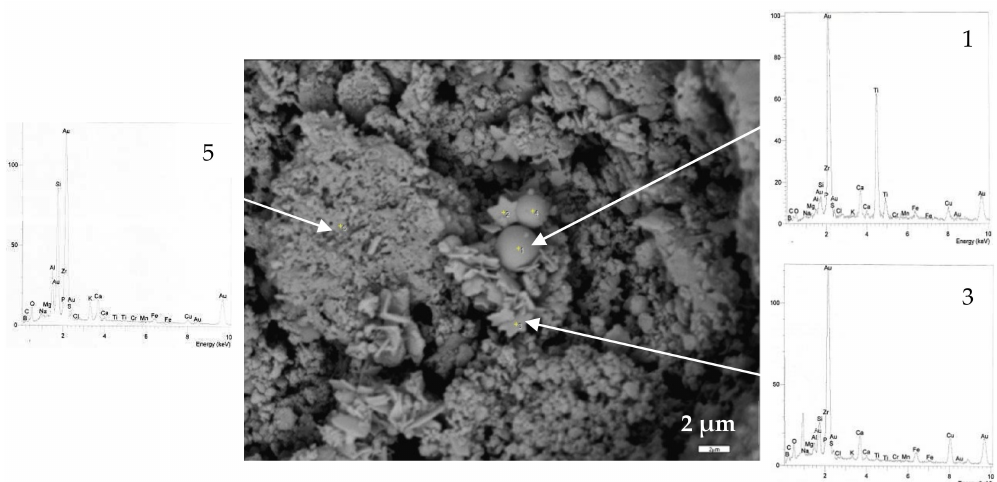
Figure 5. SEM image (3500 × ) and energy spectrum analysis of coated S10, after annealing at 600 ◦ C for 1 h.